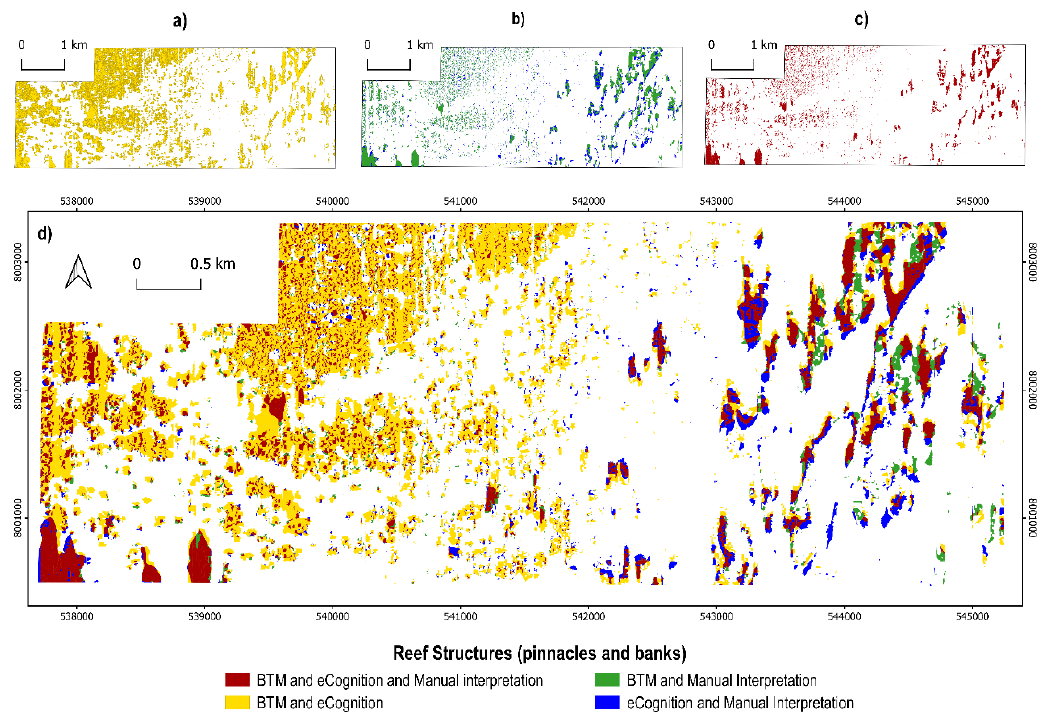
Figure 8. ( a ) Intersection of reef structures mapped by BTM and OBIA; ( b ) Overlapping of reef structures mapped by “BTM and reference map” as well by OBIA and the reference map; ( c ) Intersection among the three techniques; ( d ) Spatial distribution of all mapped reefs indicated by the two automatic classification techniques and the reference map, as well as the intersection and spatial coverage indicated by both.